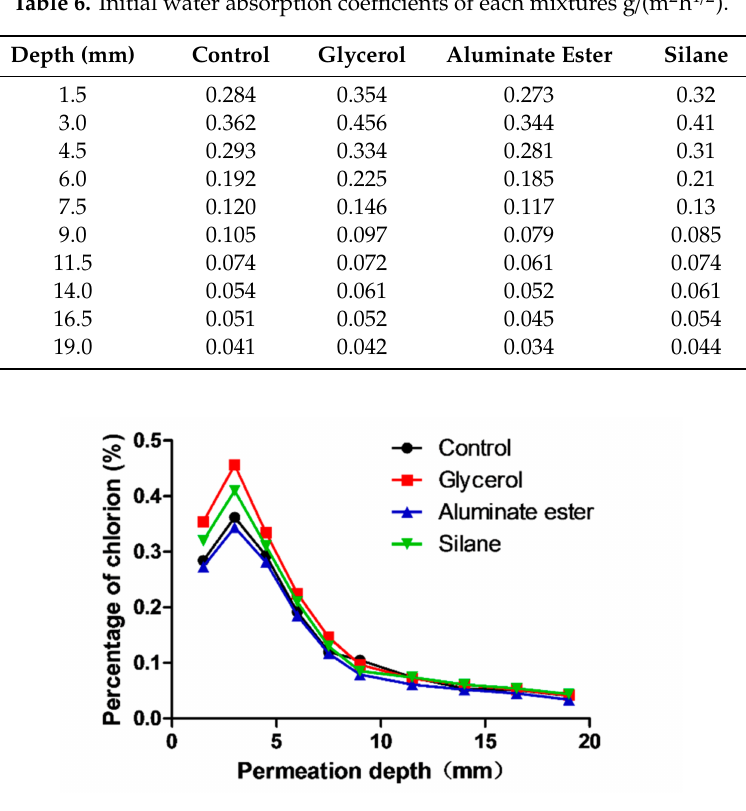
Figure 8. Chloride penetration depth due to sorptivity at 7 d.